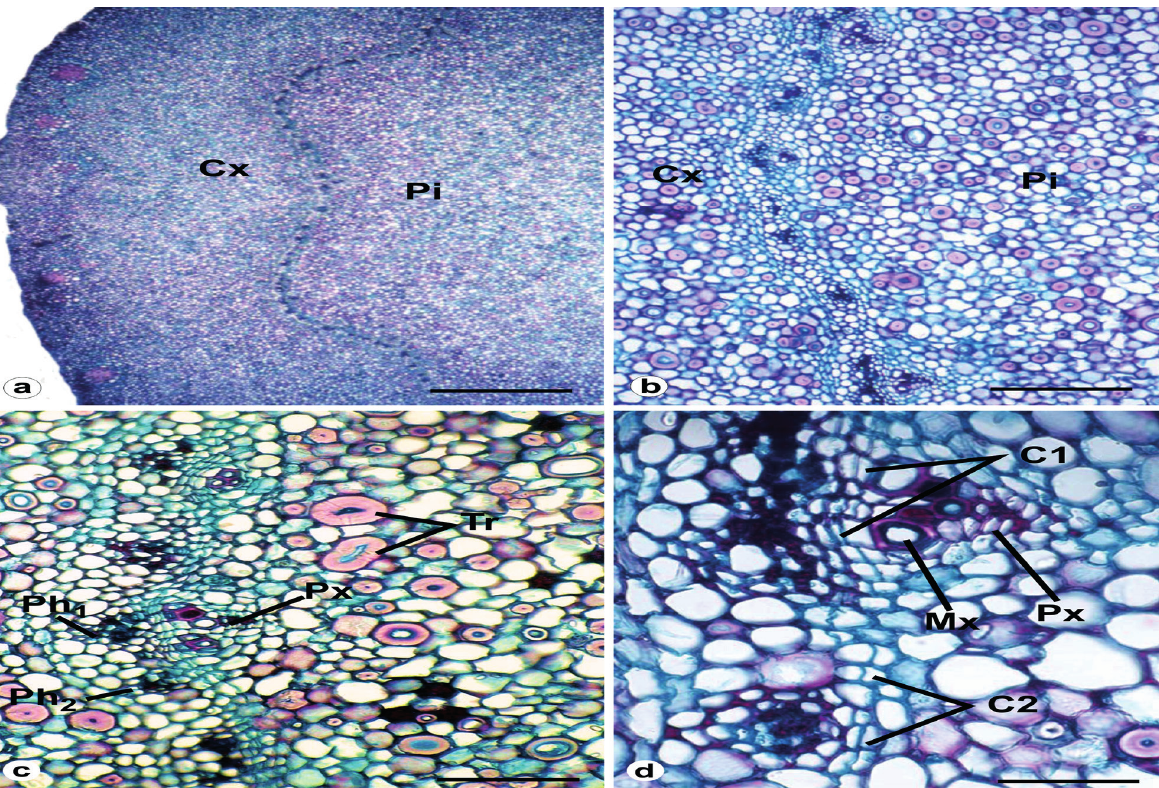
Figure 4 - (a-d) : Rhizophora mangle - Transverse sections in the region indicated by arrows in figure 3f - The cauline nature of the structure can be seen with a broad medulla (Pi) and a less well-developed cortex (Cx), with vascular bundles composed of phloem (Ph ) and xylem with endarch protoxylem (Px). Phloem strands (Ph l fascicular cambium; C2 - interfascicular cambium; Mx-metaxylem;